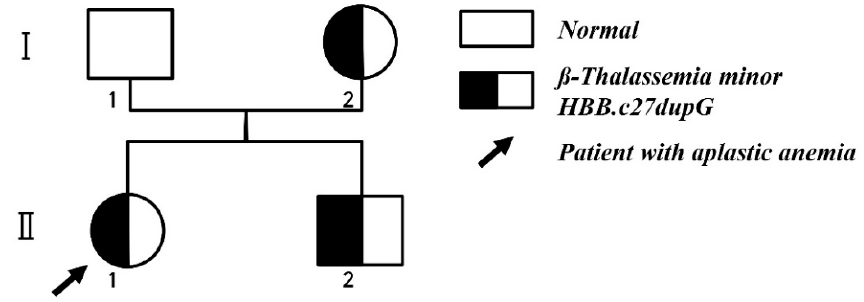
Figure 1. Pedigree of proband (black arrowhead) with aplastic anemia and β -thalassemia minor.